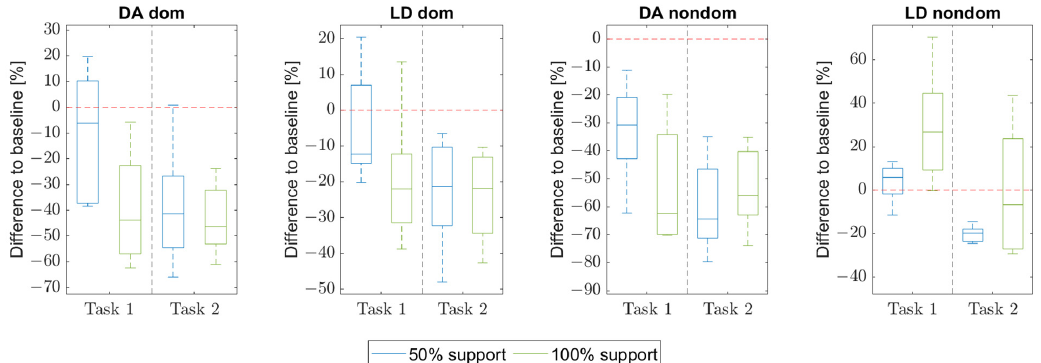
Figure 13. Differences in the mean EMGs of the DAs and LDs under conditions S50 and S100 compared to S0 during the arm lowering phase of the motion in both tasks.